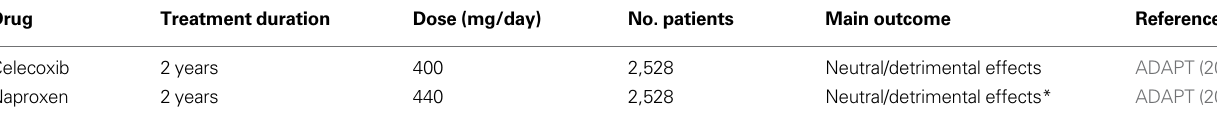
Table 4 | Double-blind, randomized, placebo-controlled primary prevention studies of NSAIDs in AD. Drug Treatment